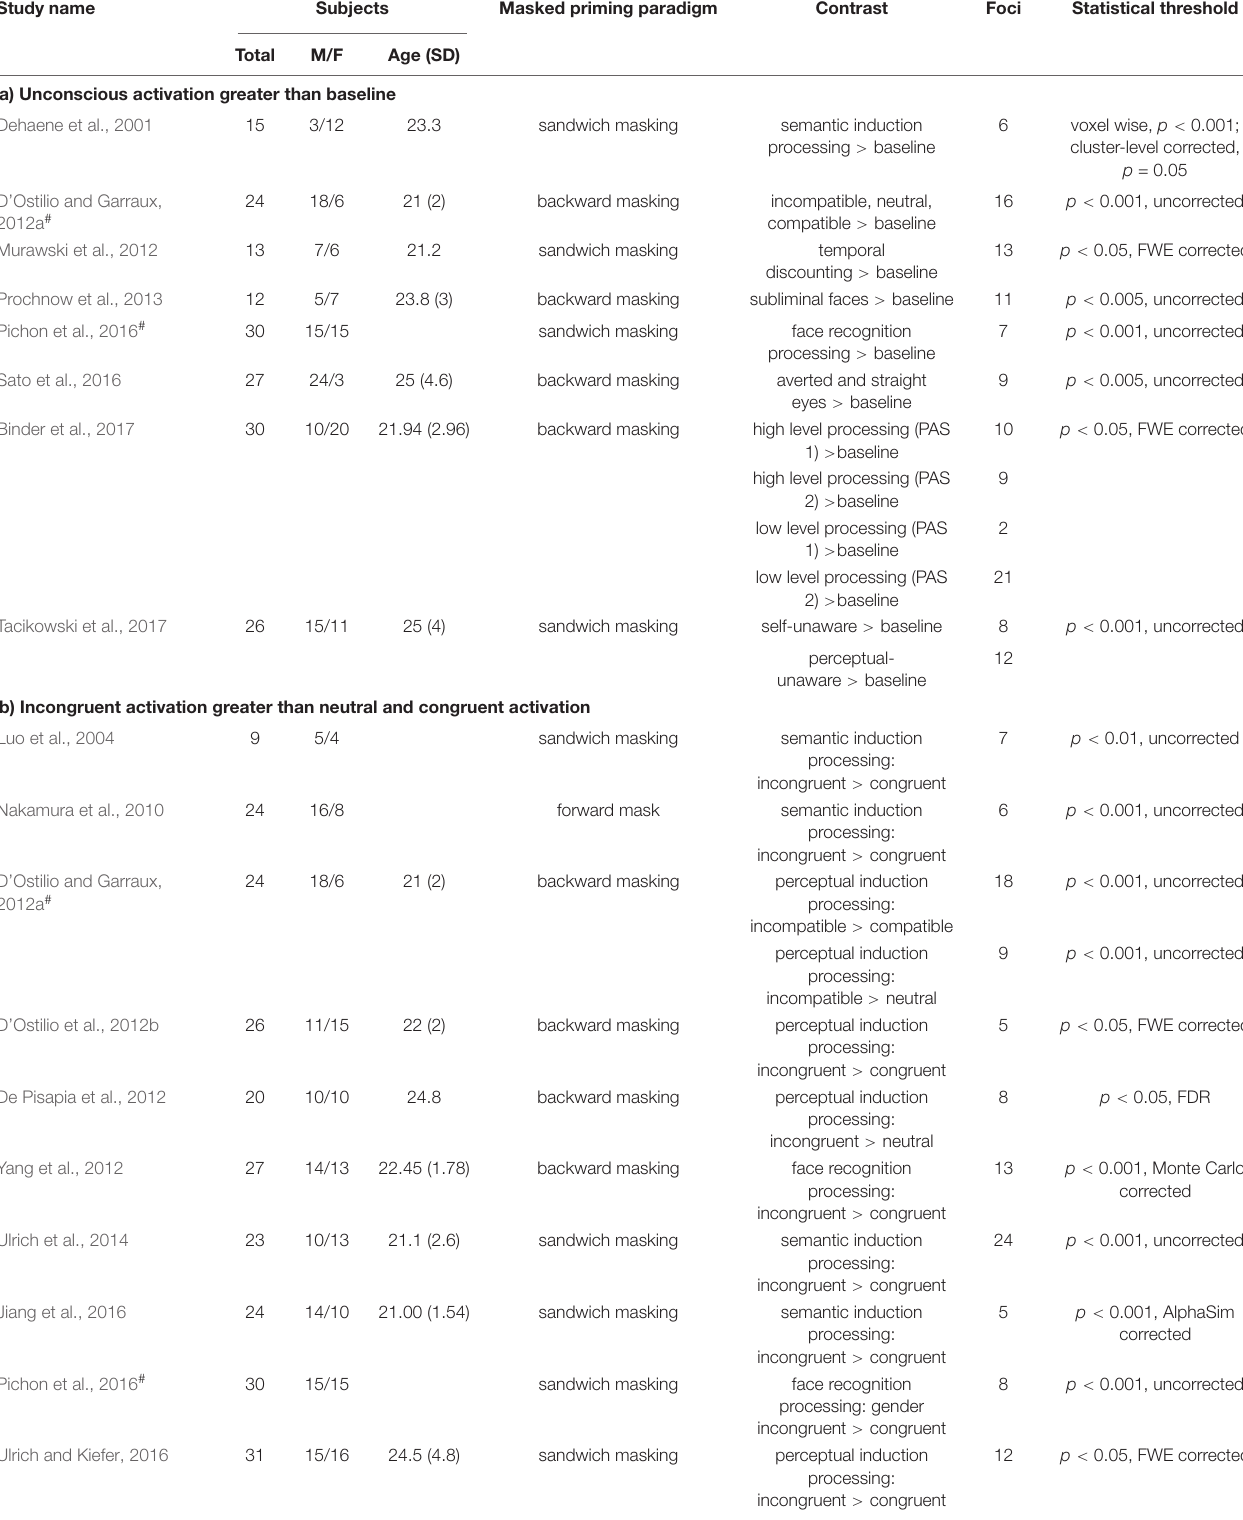
TABLE 1 | List of studies included in the ALE